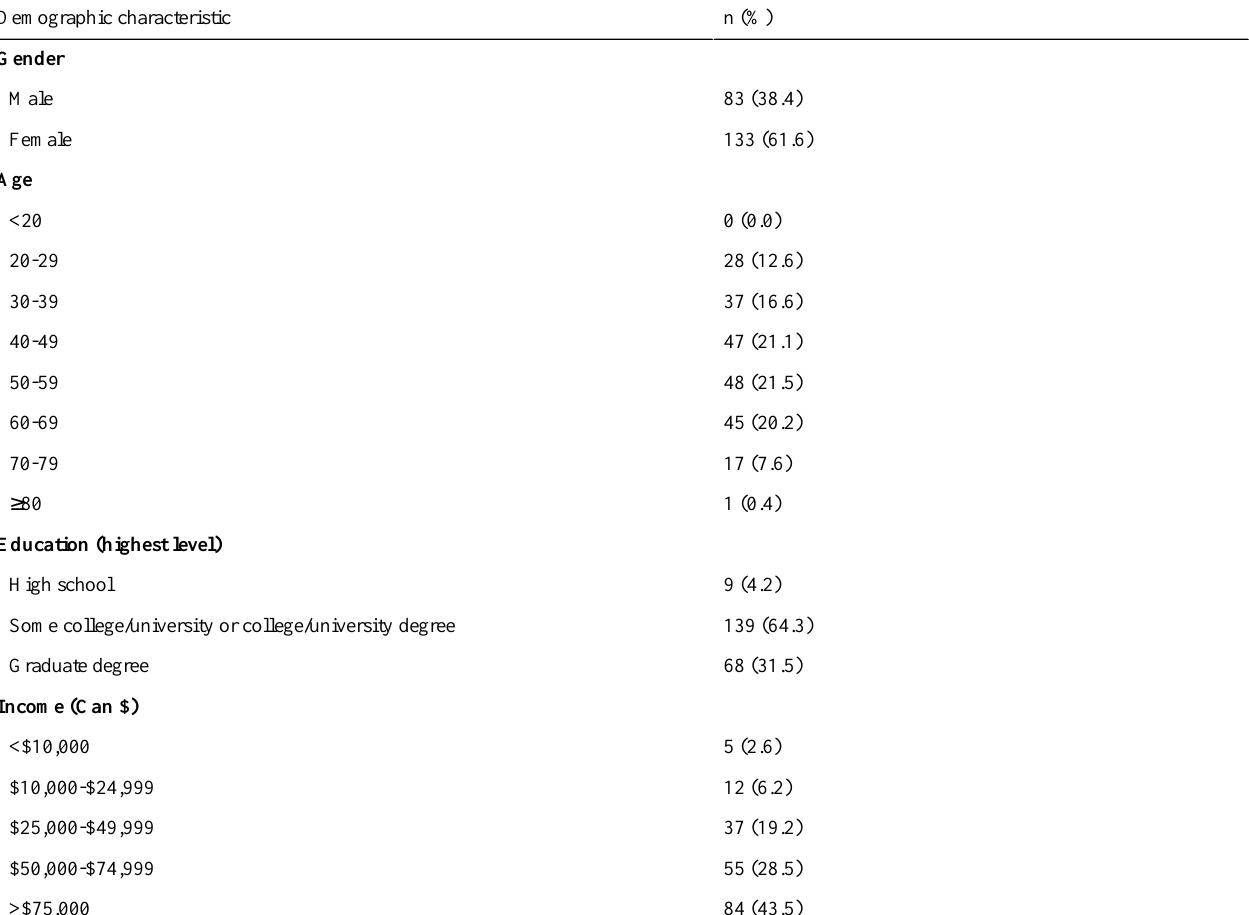
Table 1. Sample demographics